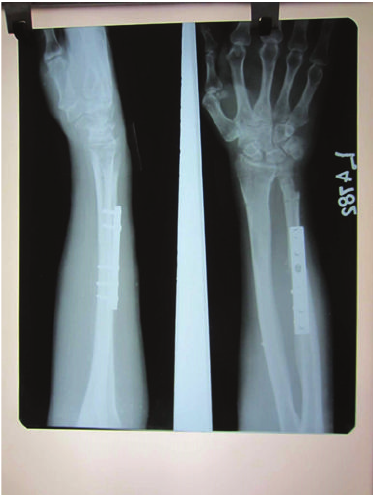
Figure 14: X-ray at 1-year followup.